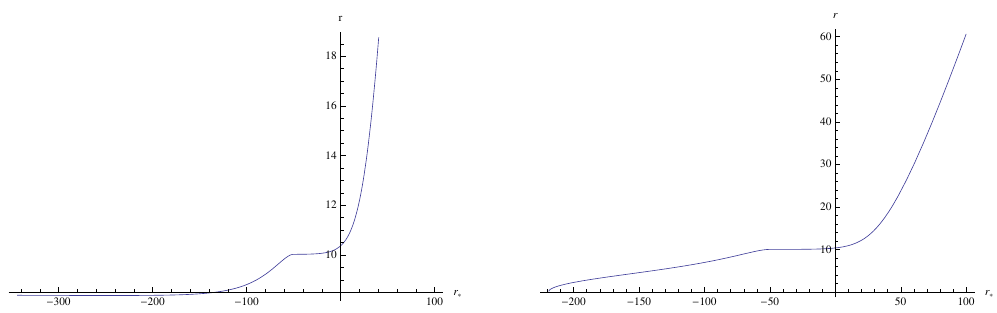
Figure 14 . Behavior of r for the surface r s close to but outside the neck at r = a . Here we take r (cid:3) s = (cid:0) 50 > a (cid:3) ’ (cid:0) 56 : 685, a 0 = 10 and (cid:11) = 0 : 05. For (cid:20)m 0 = 5 (left), the turning point of r is around r (cid:3) = (cid:0) 243, where r = 8 : 36. For (cid:20)m 0 = 10 (right), there are no turning point of r and r approaches to r e scale at (cid:12)nite r (cid:3) .